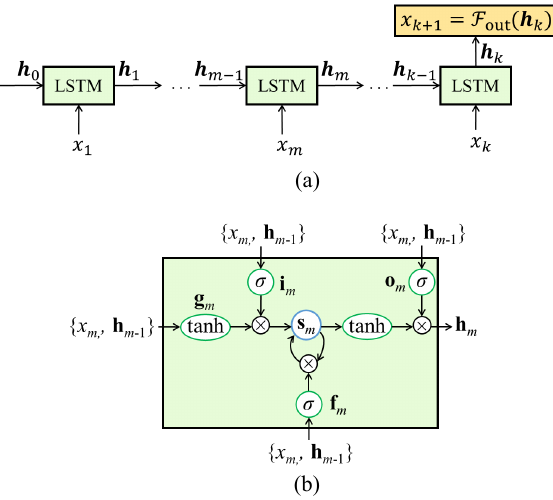
Figure 2. ( a ) Unfolded basic RNN; and ( b ) LSTM cell